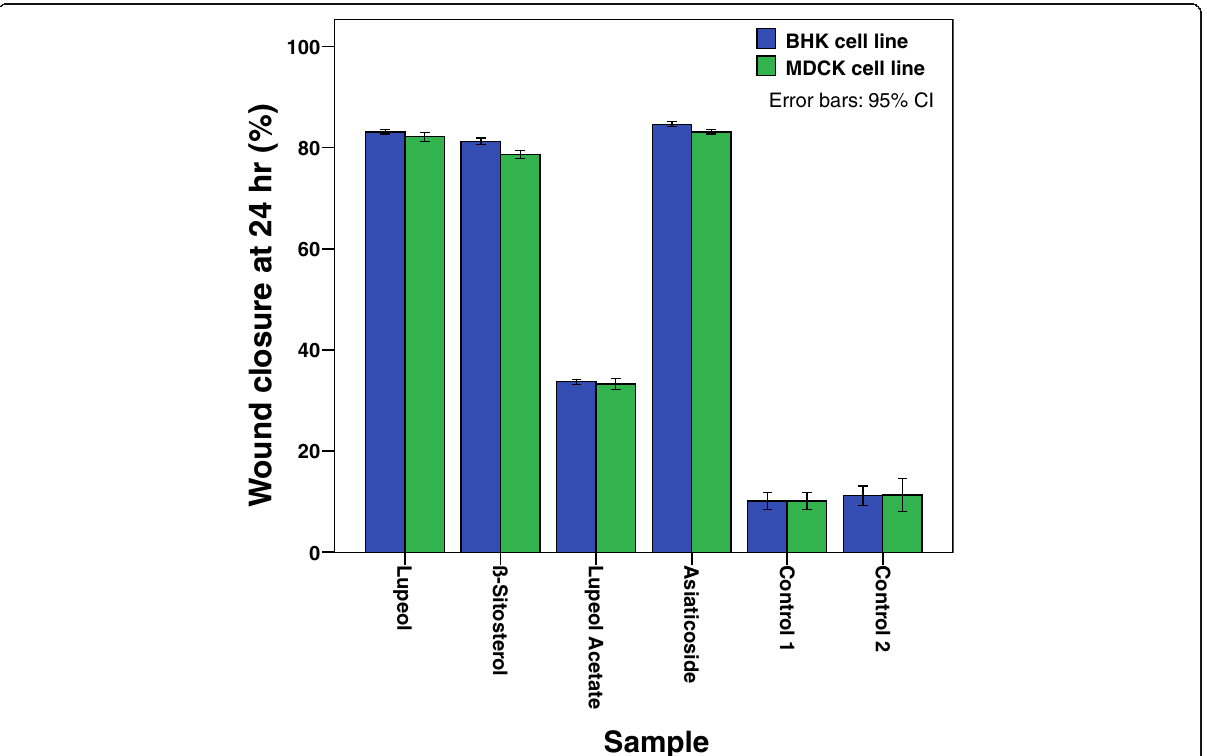
Fig. 5 Percentage wound closure in the presence of lupeol ( 1 ), β -sitosterol ( 2 ), lupeol acetate ( 3 ) and positive control asiaticoside